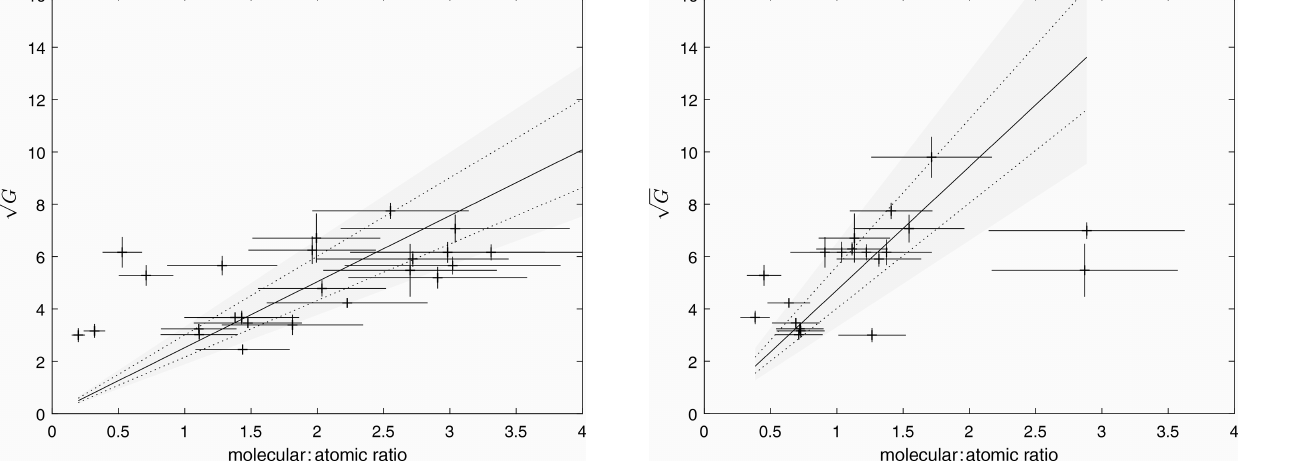
√ Figure 4. The same as for Fig. 3 but with the heights of the F1 peak G (obtained from the model fit to ionograms) Figure 3. A plot of determined from the ionogram inversion algorithm ARTIST. The versus the thermospheric molecular-to-atomic ratio calculated from resulting fit yields a gradient of 4 . 75 ± 0 . 8. the associated TIMED neutral density profile. For each data point, the fitted scale height at the F1 peak was used to estimate the ther- mospheric temperature. This was then used to identify the appro- priate height at which to interpolate the thermospheric composition ratio from the TIMED data set. The solid line represents a weighted linear least-squares fit to the data, while the dotted lines represent the 95th percentiles; the grey shaded area represents the range of gradients from a distribution of 1000 fits in which the values were randomly sampled from the uncertainty distributions.